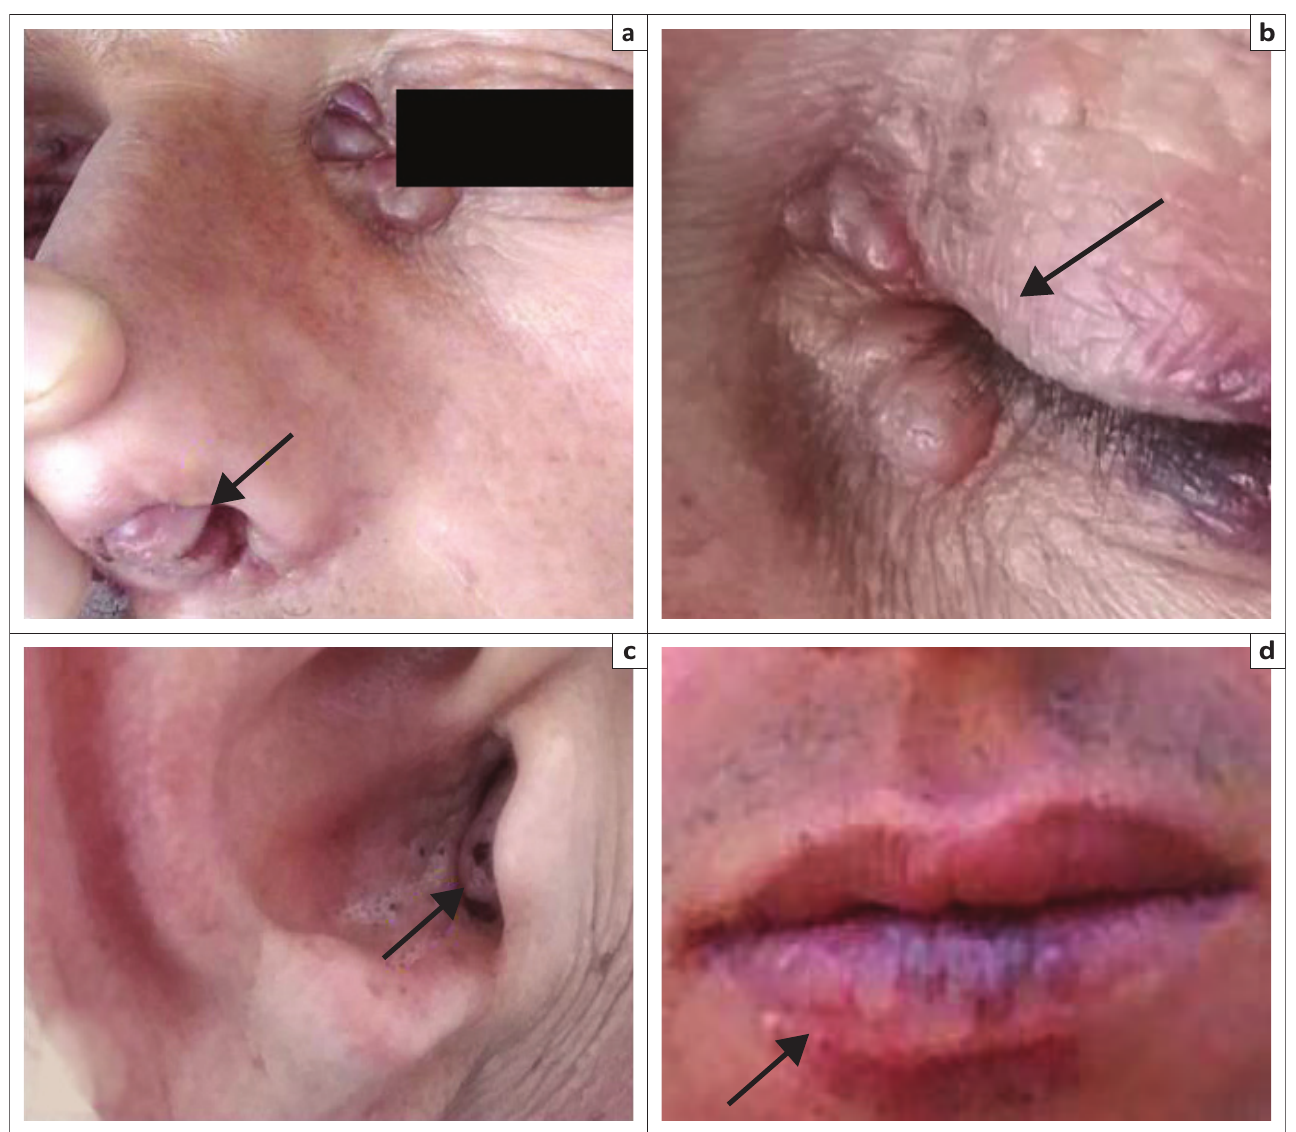
FIGURE 1: Appearence of (a, b) multiple nodular lesions around the eyes and within both nostrils (c) on the right external ear canal (d) and the lesions on the lower